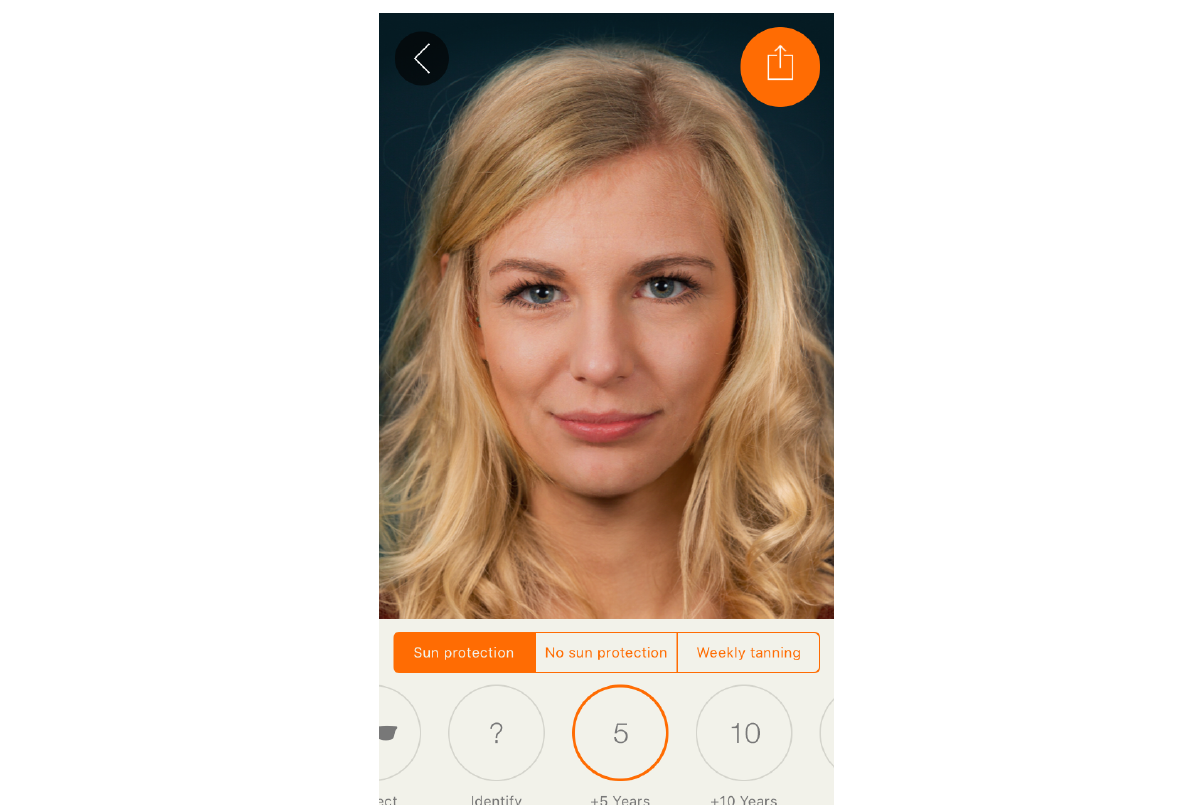
Figure 4. Effect view of the app: 5 years of normal aging with daily sun protection